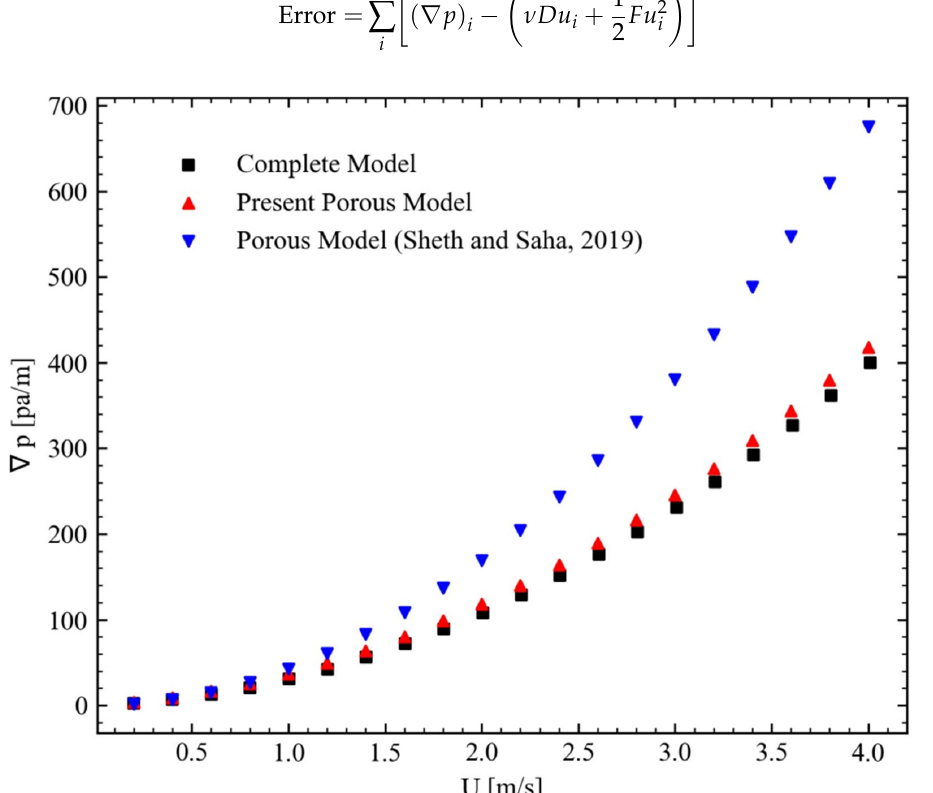
Figure 14. Variations of the pressure drop with the inlet velocity using different models for the inactive server [25]. Table 3. Darcy and Forchheimer coefficients for inactive and active servers.